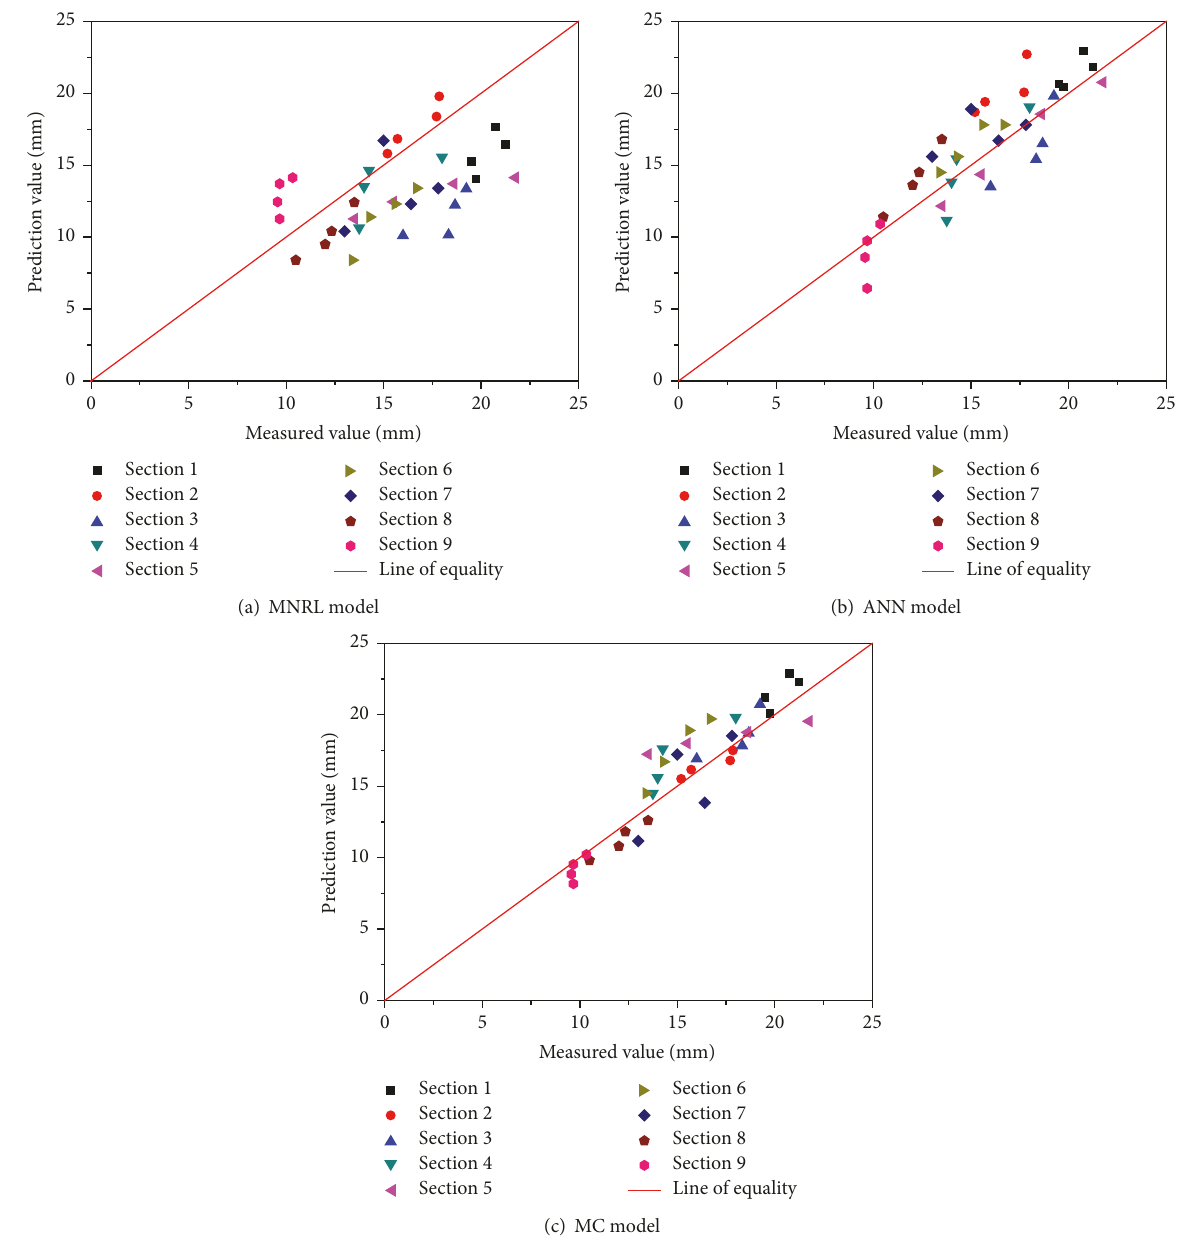
Figure 2: Predicted faulting versus measured